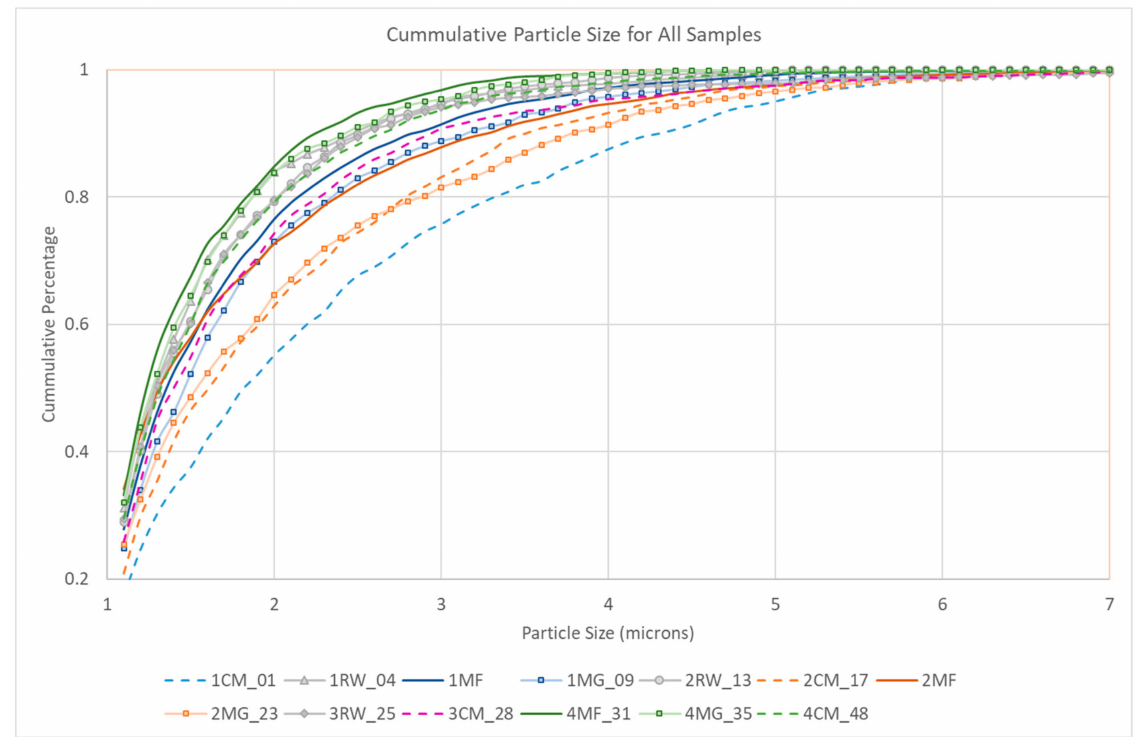
Figure 4. Cumulative particle size for all samples. X-axis = particle size (microns) and y-axis = cumulative percentage